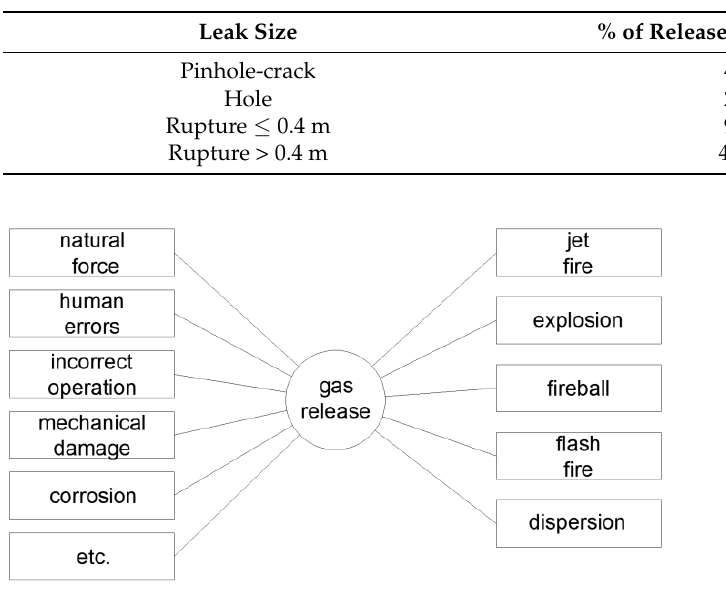
Table 3. Ignition of releases per leak type—EGIG report [4].